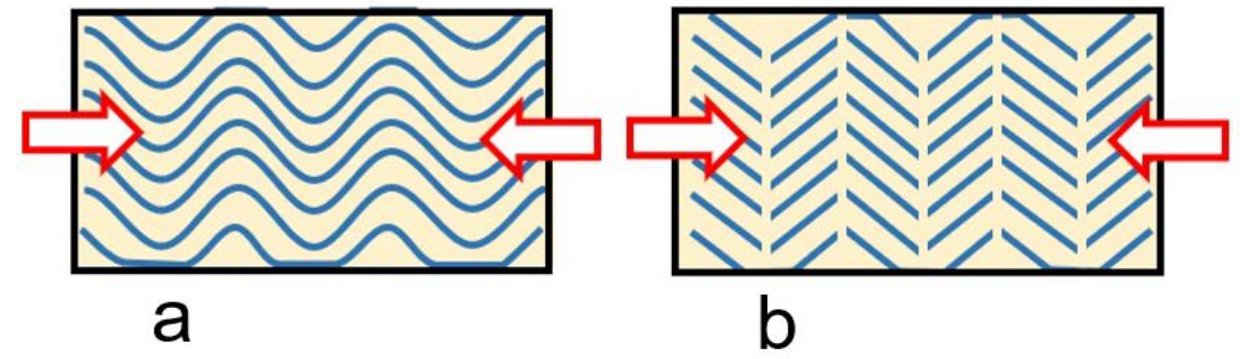
Figure 8. The development of the herringbone texture from the smoothly curved meandering pattern ( a ) to the broken zig-zag drawn in ( b ).